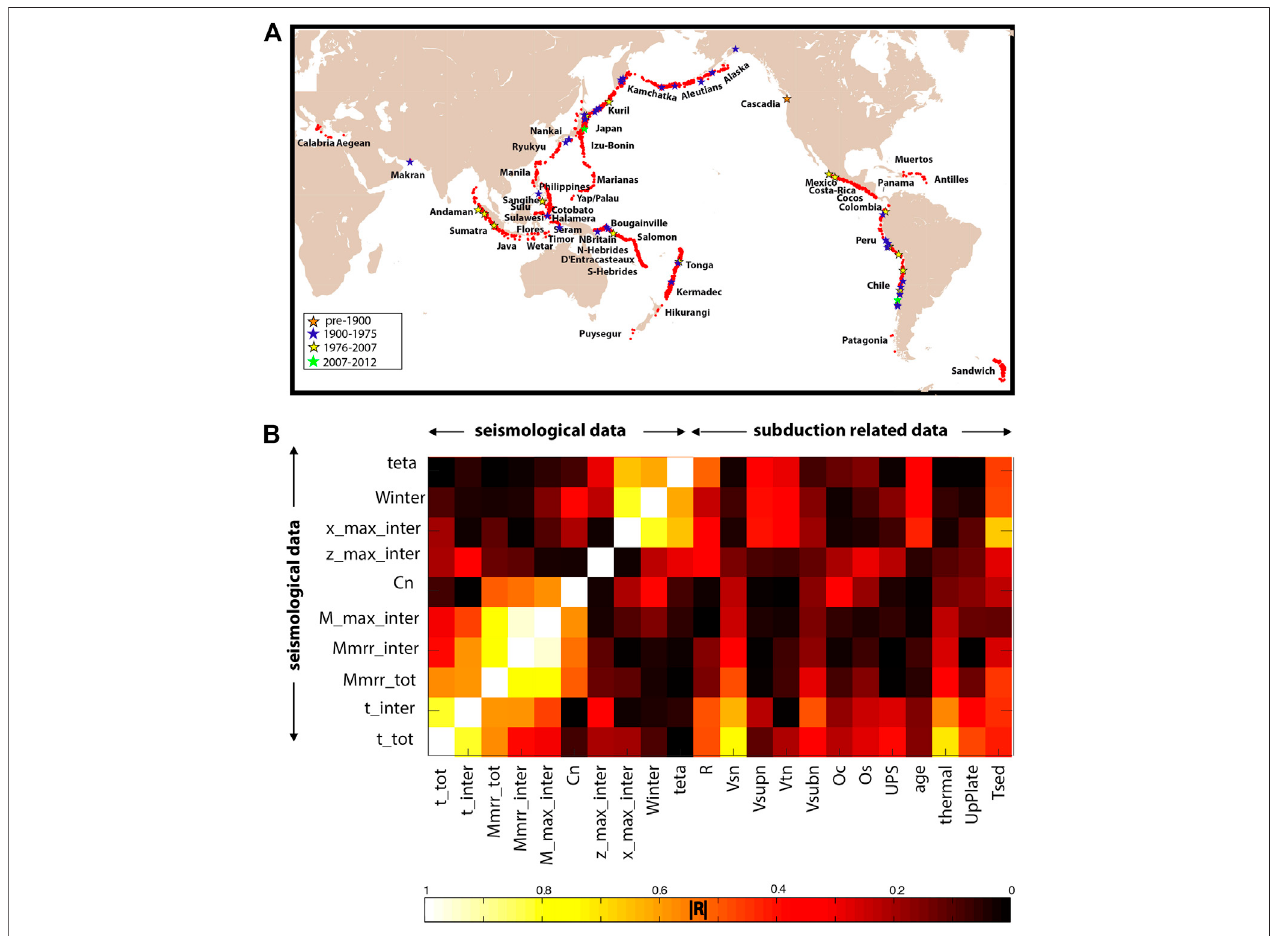
FIGURE1 |(A) Map ofthe subduction interface seismicity (redrawn from Heuret et al., 2011). M w ≥ 8.0subduction interface eventsare plotted bystars ofdifferent colours, representing the interval of occurrence of the events. The largest events are not homogeneously distributed in space and time along the worldwide subduction zones; (B) Correlation matrix used to show the dependence between multiple variables at a glance. The table contains the modulus of the Pearson ’ s product moment correlation coef fi cient R of linear bivariate regressions between seismogenic zone parameters (t_tot: total seismic of subduction zones; t_inter: seismic rate due to interplate earthquakes; Mmrr_tot: total moment release rate of subduction zones; Mmrr_inter: moment release rate due to interplate events; Mmax_inter: maximum magnitude of interplate events; Cn: seismic coupling coef fi cient; zmax_inter: downdip limit of the subduction thrust fault; zmin_inter: updip limit of the subduction thrust fault) and other independent subduction parameters (Tsed: thickness of sediments at the trench; UpPlate: nature of the upper plate; thermal: thermal parameter; age: ageofthesubductinglithosphereatthetrench;Vsn:normalcomponentofthesubductionvelocity;Vsupn:normalcomponentoftheoverridingplatevelocity;Vts:normal component of the trench velocity; Vsubn: normal component of the subducting plate velocity; Oc: convergence obliquity; Os: subduction obliquity; R: radius of bending of the slab) as attempt to unravel the overall behavior of subduction by comparing a wide range of observables (see Heuret et al., 2011 for additional details).